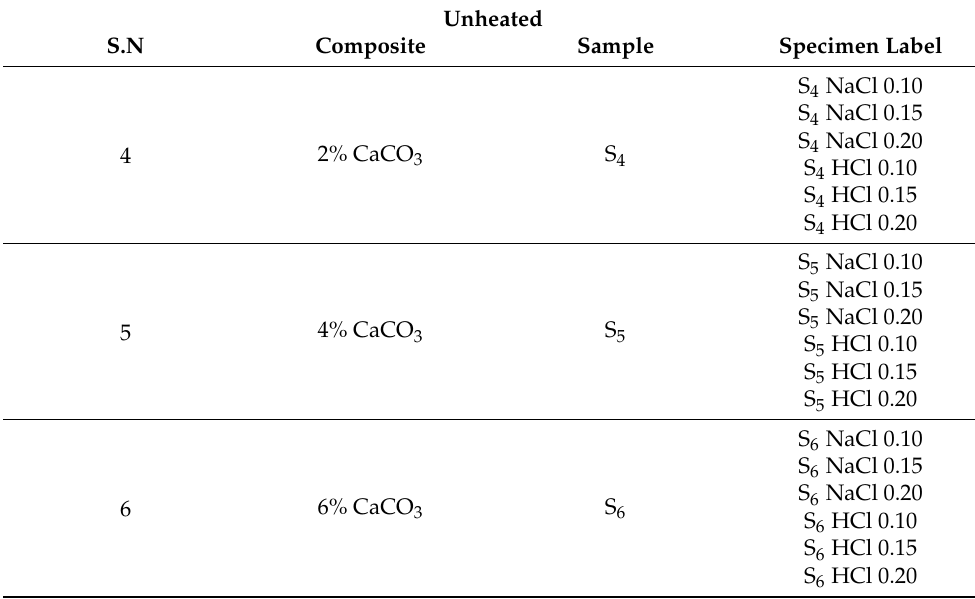
Table 3. Unheated CaCO 3 specimens with their labels and